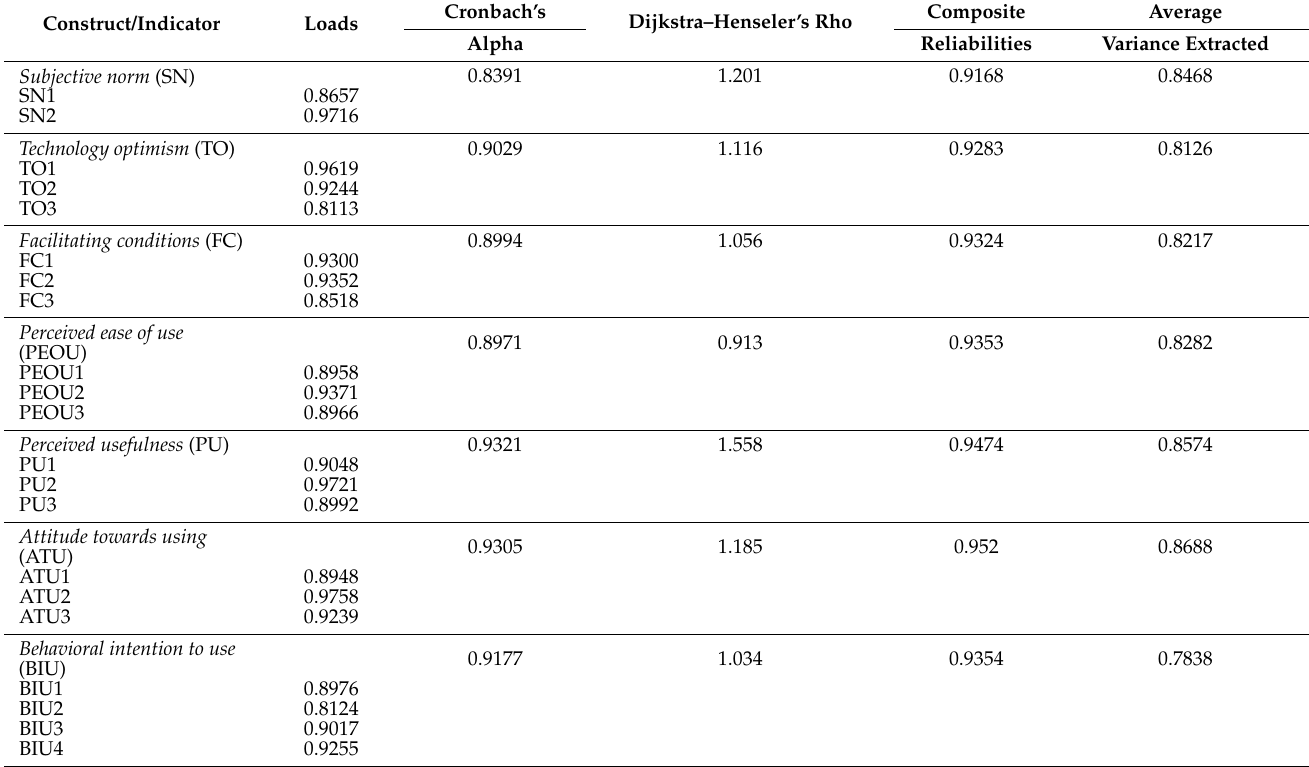
Table 2. Evaluation of the measurement model.